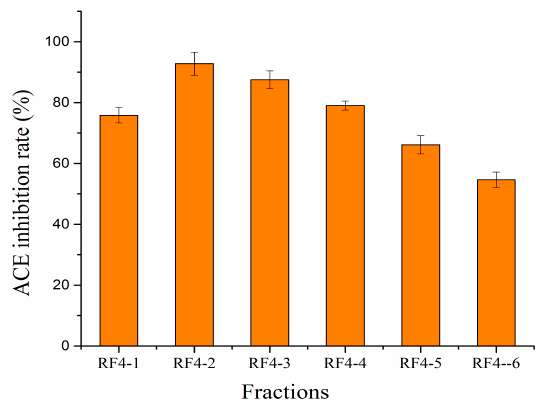
Figure 9. The ACE-inhibitory activity assay of different MW fractions. The aqueous solutions of fractions were 2 mg/mL.